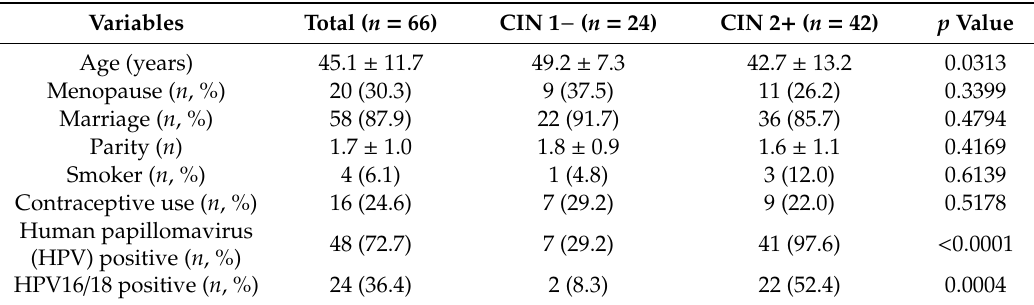
Table 1. Participants’